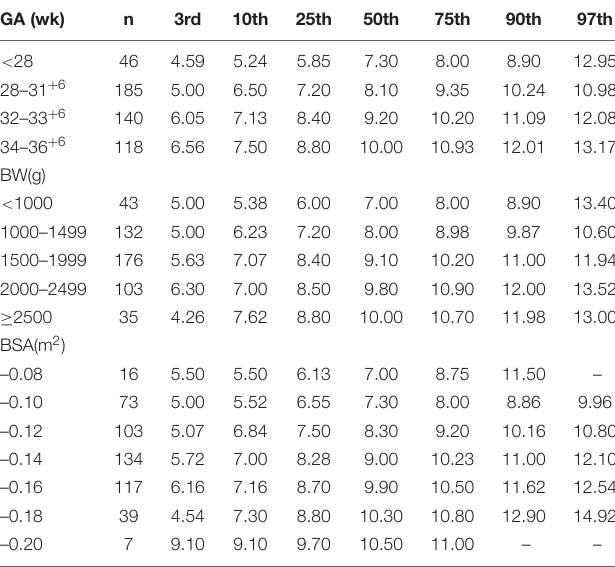
TABLE 4 | Left ventricular end-systolic dimensions (mm) (from 3rd to 97th centiles) in relation to GA, BW, and BSA in preterm